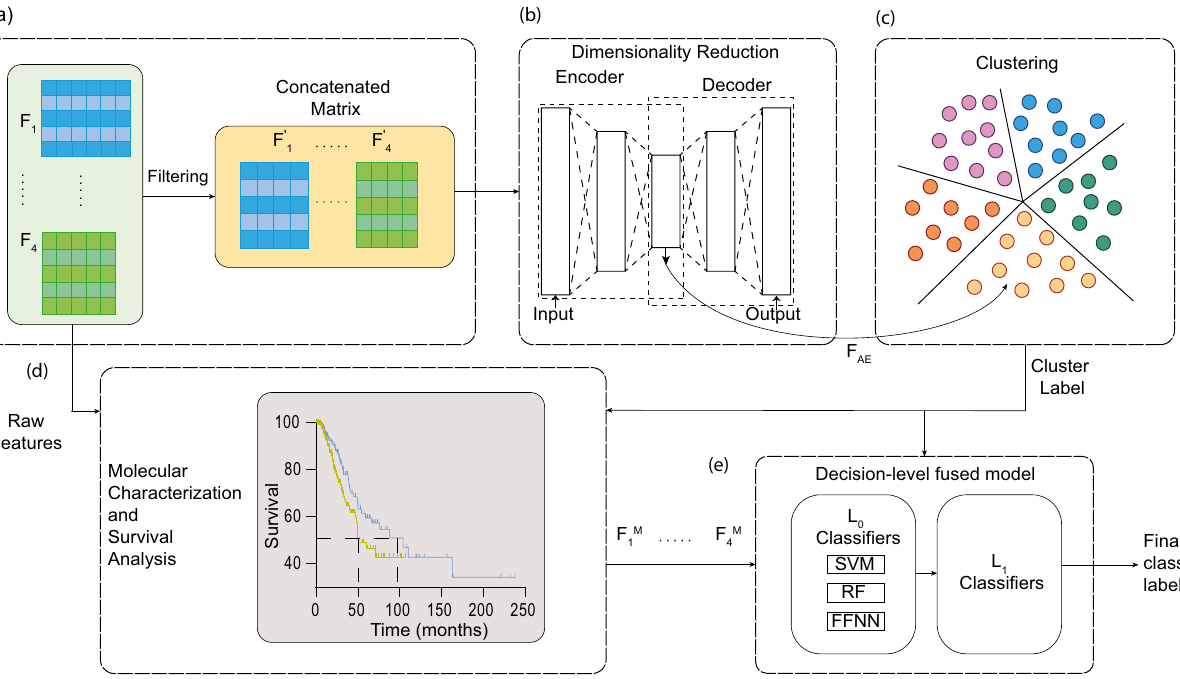
Figure 1. Overall pipeline followed in this work. ( a ) Each level of evidence (single-omic) was preprocessed and multi-omics representation was obtained by stacking the features for feature-vectors (samples) common across them. ( b ) The latent representation of multi-omics data (F AE ) was obtained using an autoencoder (AE). ( c ) Consensus K -means clustering was applied on the reduced dimension representation to obtain the cluster labels. ( d ) Molecular characterization of samples in clusters obtained was carried out to understand the subgroups. ( e ) Decision-level fused classifiers obtained by the combination of classification models including, support vector machines (SVM), random forest (RF), and feed-forward neural network (FFNN) was proposed for subgroup identification.